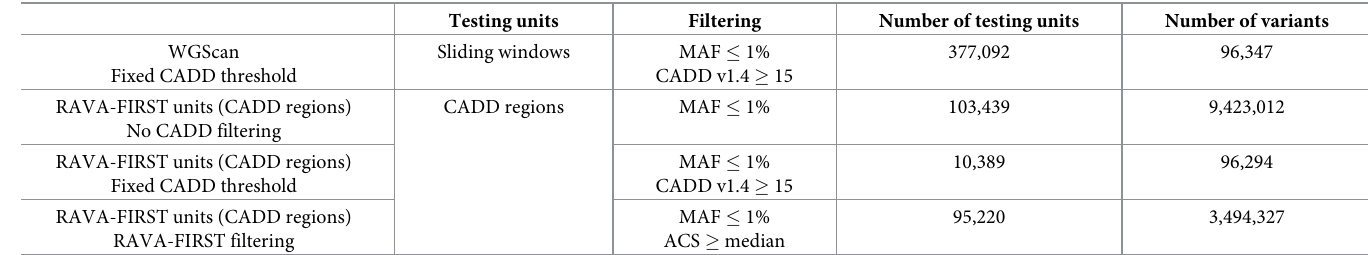
Table 4. Number of testing units and variants kept under the three